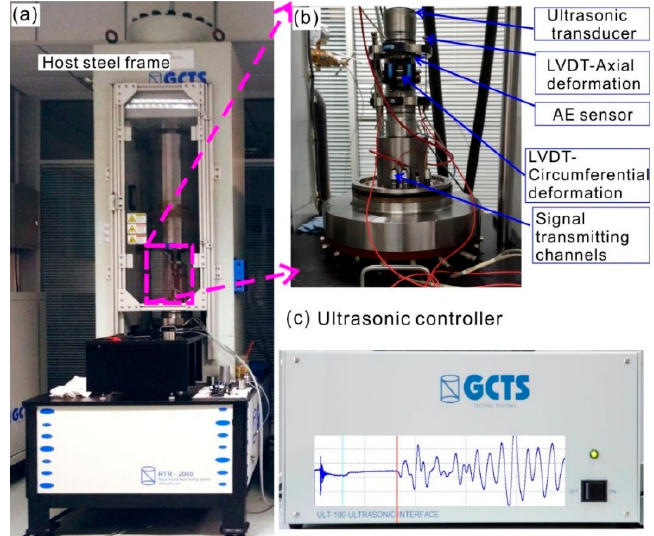
Figure 3. Testing system for the granite samples after F–T treatment. ( a ) GCTS RTR 2000 rock mechanics machine; ( b ) LVDT system and acoustic emission (AE) sensors; ( c ) ultrasoinc measurement